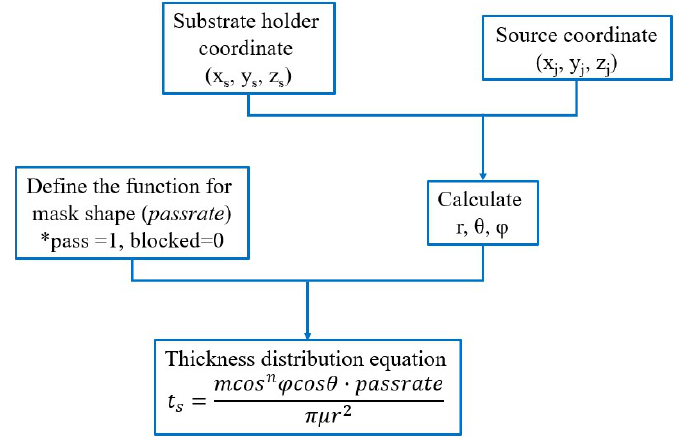
Figure 21. The evaporation flow chart of the simulation on thickness distribution; passrate is a